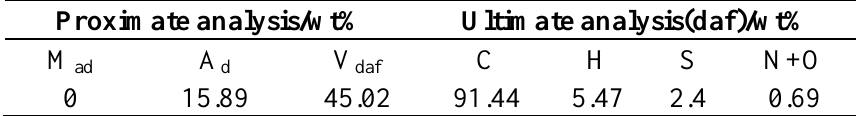
Table 1. Proximate analysis and ultimate analysis of Shenhua